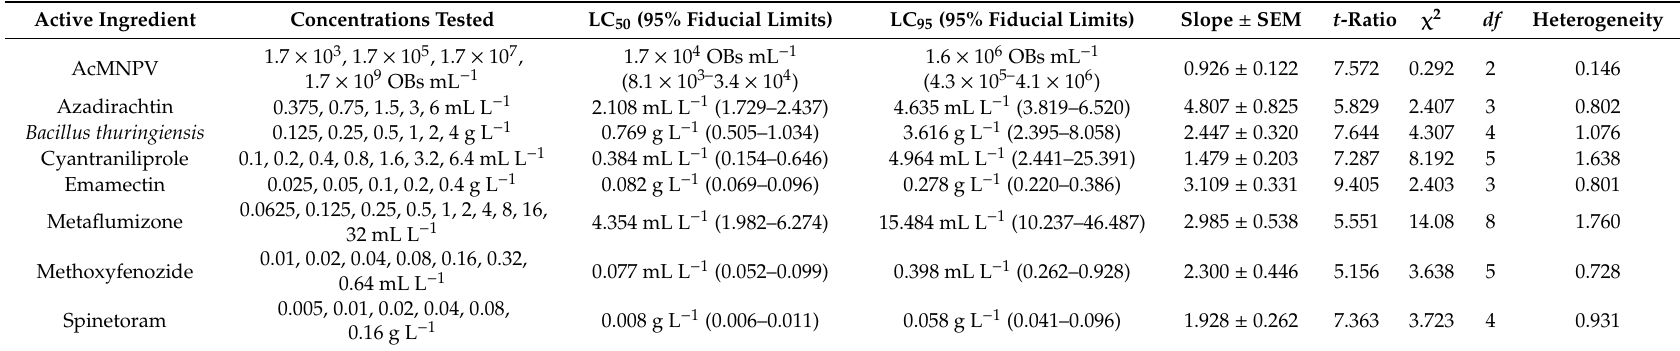
Table 2. Probit regressions of insecticides on Spodoptera exigua second instar larvae, showing the concentrations tested, the LC 50 and LC 95 with upper and lower fiducial limits at 95%, slope ± SEM, t -ratio and statistics according to POLO-Plus program ( p ≤ 0.05).